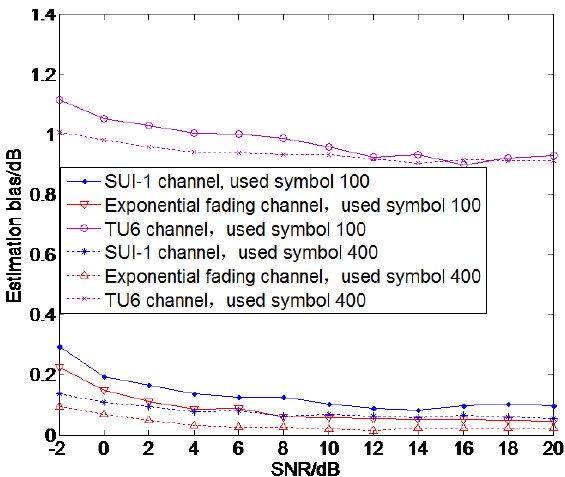
Figure 4. Comparison of the Input Signal-Noise-Ratio (SNR) with the Estimated SNR.